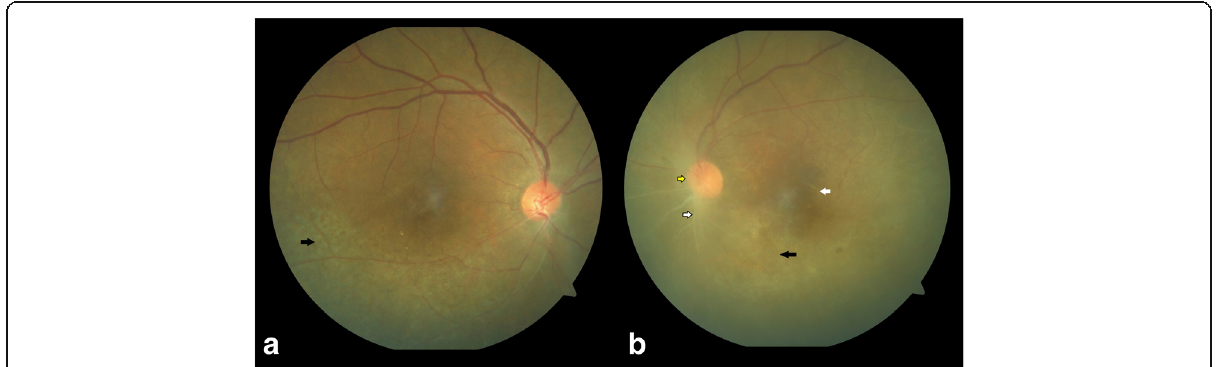
Fig. 6 Color fundus photo at 6 weeks follow up of a the right eye showing pigmentary alterations (black arrow) along the inferotemporal arcade and b the left eye showing disc pallor (yellow arrow with black border), sclerosed vessels (white arrow with black border), pigmentary alterations (black border), and epiretinal membrane (white arrow) at the macula